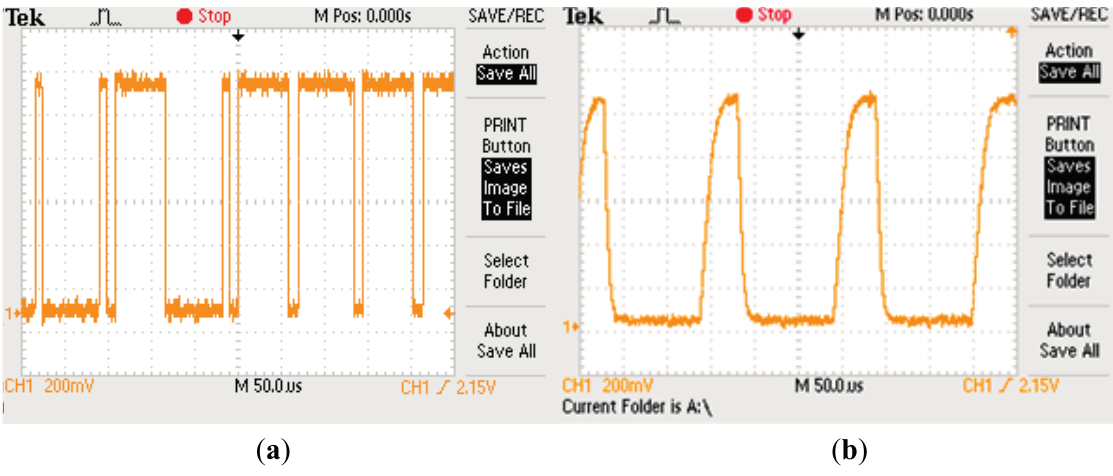
Figure 2. ( a ) Correct waveform in the bus; ( b ) Incorrect waveform (degraded) in the